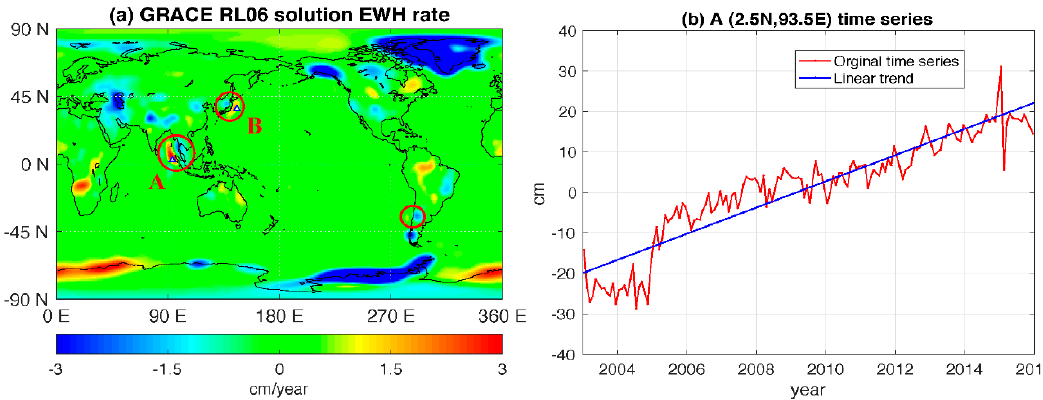
Figure 1. ( a ) The spatial distribution of equivalent water height (EWH) trend rates 2003–2015 from the Gravity Recovery and Climate Experiment (GRACE) Release-06 (RL06) solutions, with the glacial isostatic adjustment (GIA) effect removed and ( b ) the time series at point A (2.5°N, 93.5°E) from GRACE, and the linear trend fitted by least squares fitting.